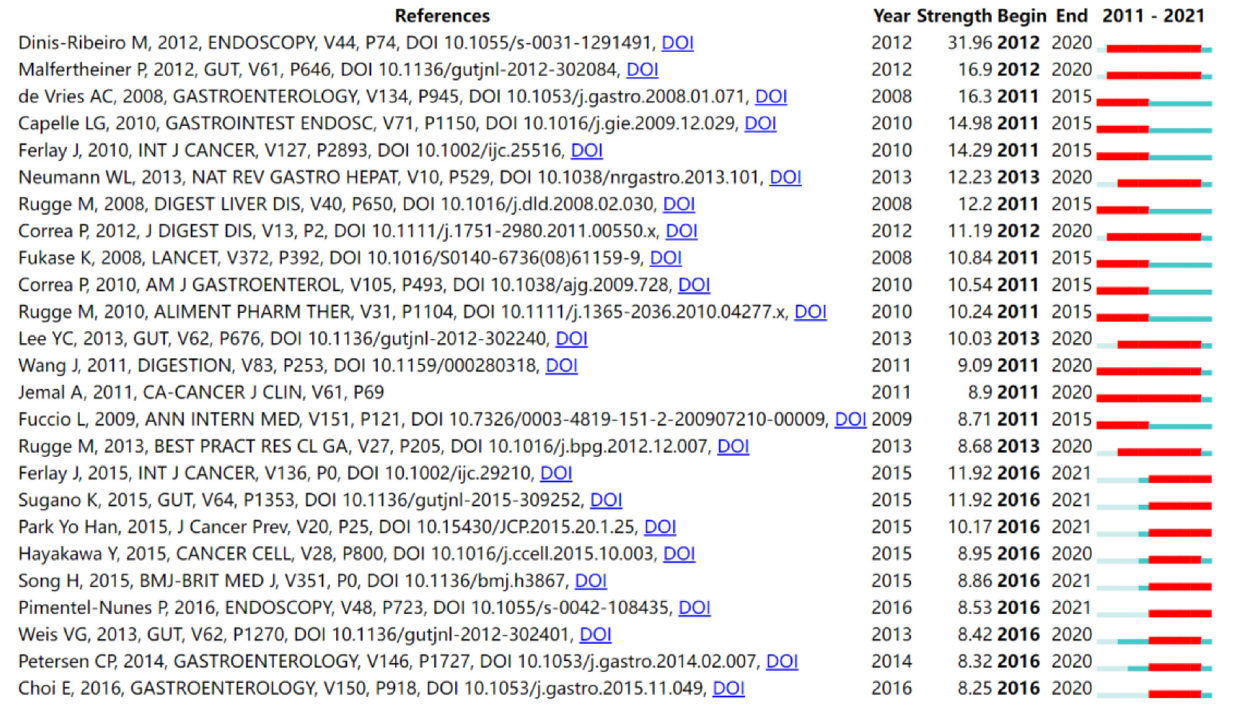
FIGURE 6 | Top 25 references with strong citation bursts in AG research.